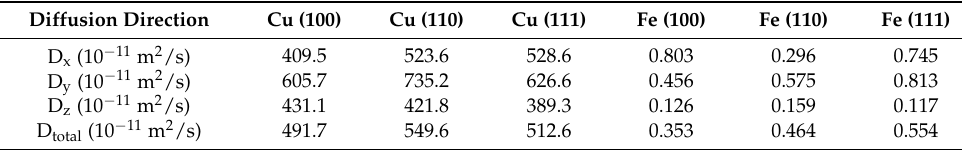
Table 1. Diffusion coefficient of atoms under different surface and orientation.